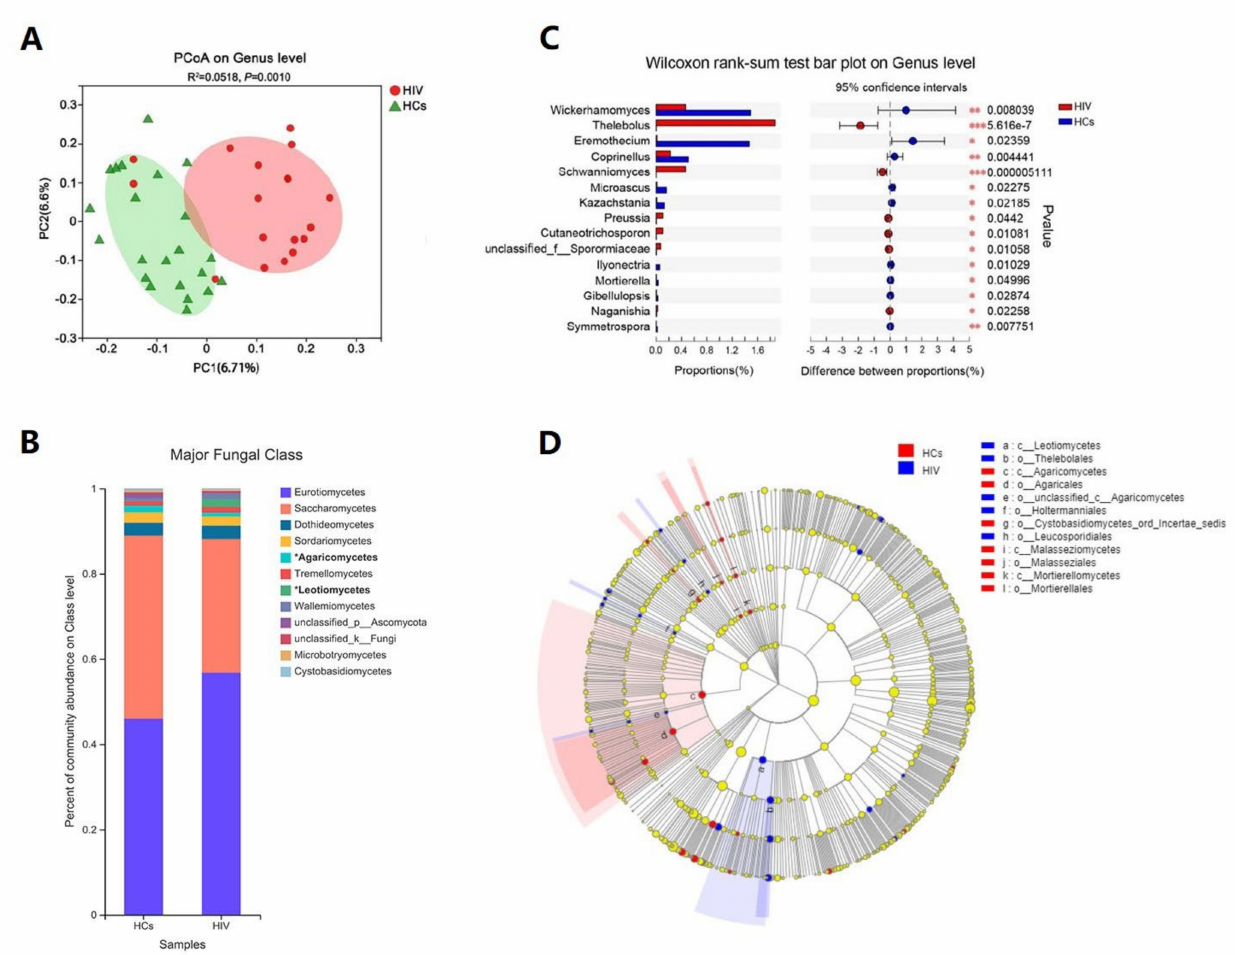
Figure 2. Characteristics of intestinal fungal spectrum in the HIV mono-infected patients and healthy control group. ( A ) Beta diversity (PCoA-based unweighted UniFrac distance matrix) between the two groups. ( B ) The changes in the intestinal fungal spectrum in the HIV group compared to the healthy controls at class level. (Classes differing significantly are marked with ‘*’.) ( C , D ) present the differences in the HIV mono-infected patients and healthy controls through the Wilcox rank-sum test and LEfSe cladogram (LDA = 2.5),